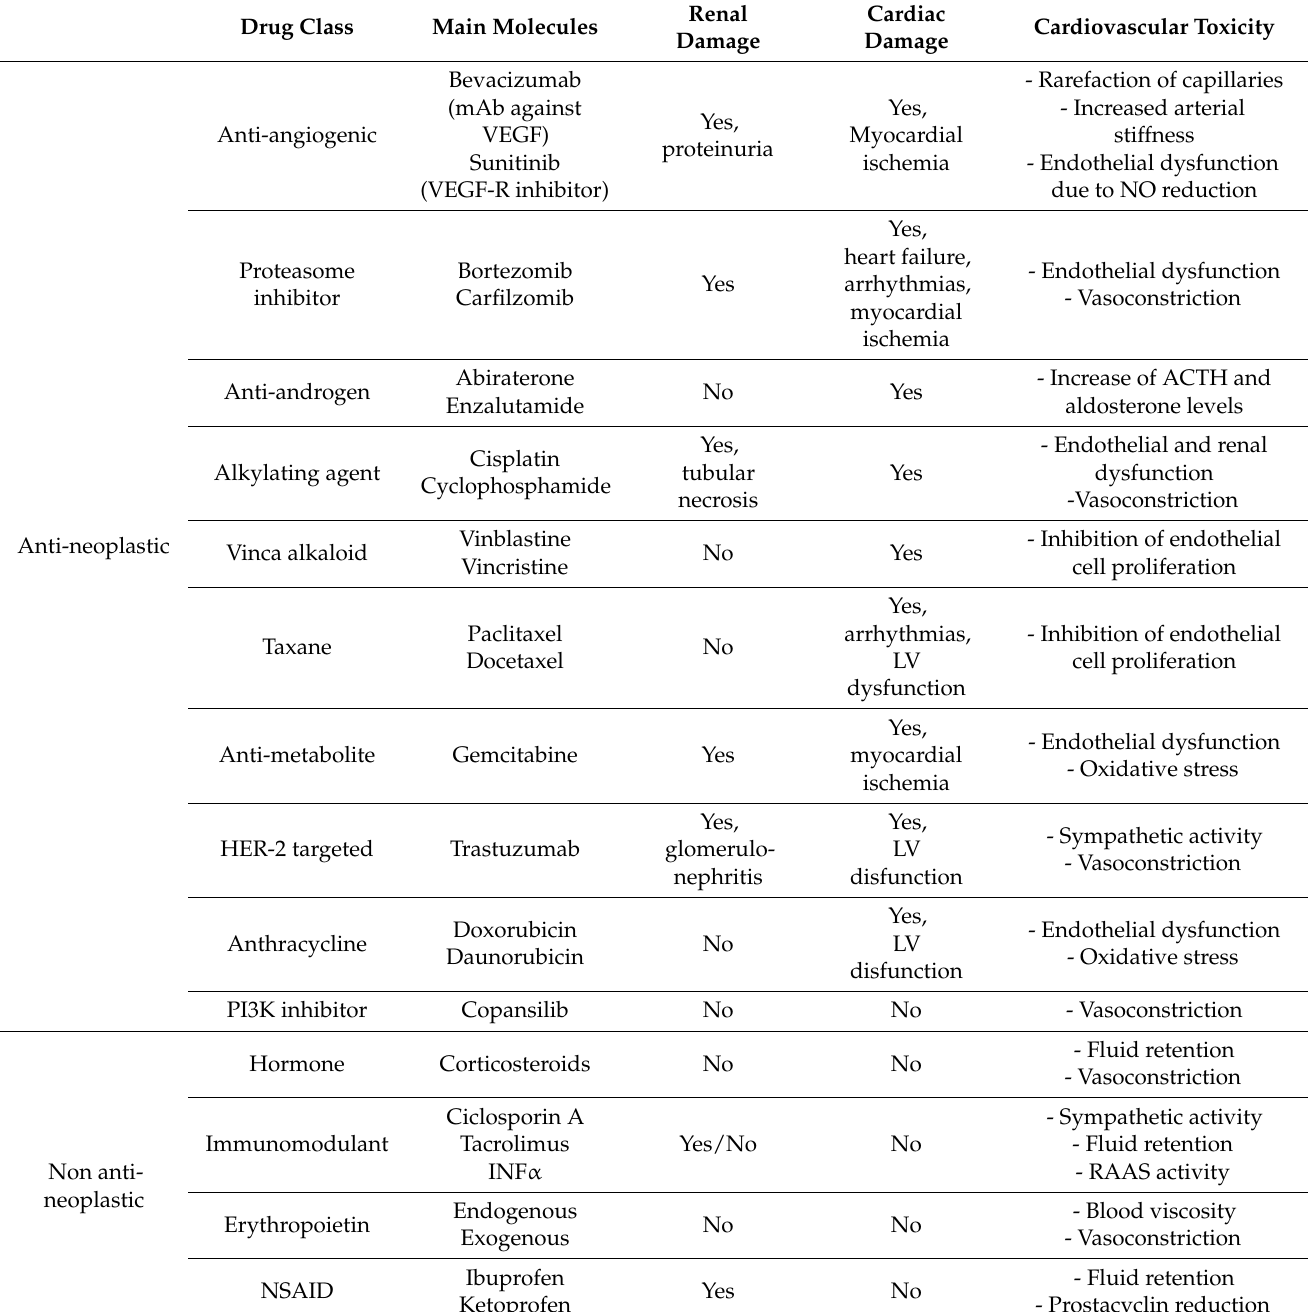
Table 1. Principle class of cancer treatments related to arterial